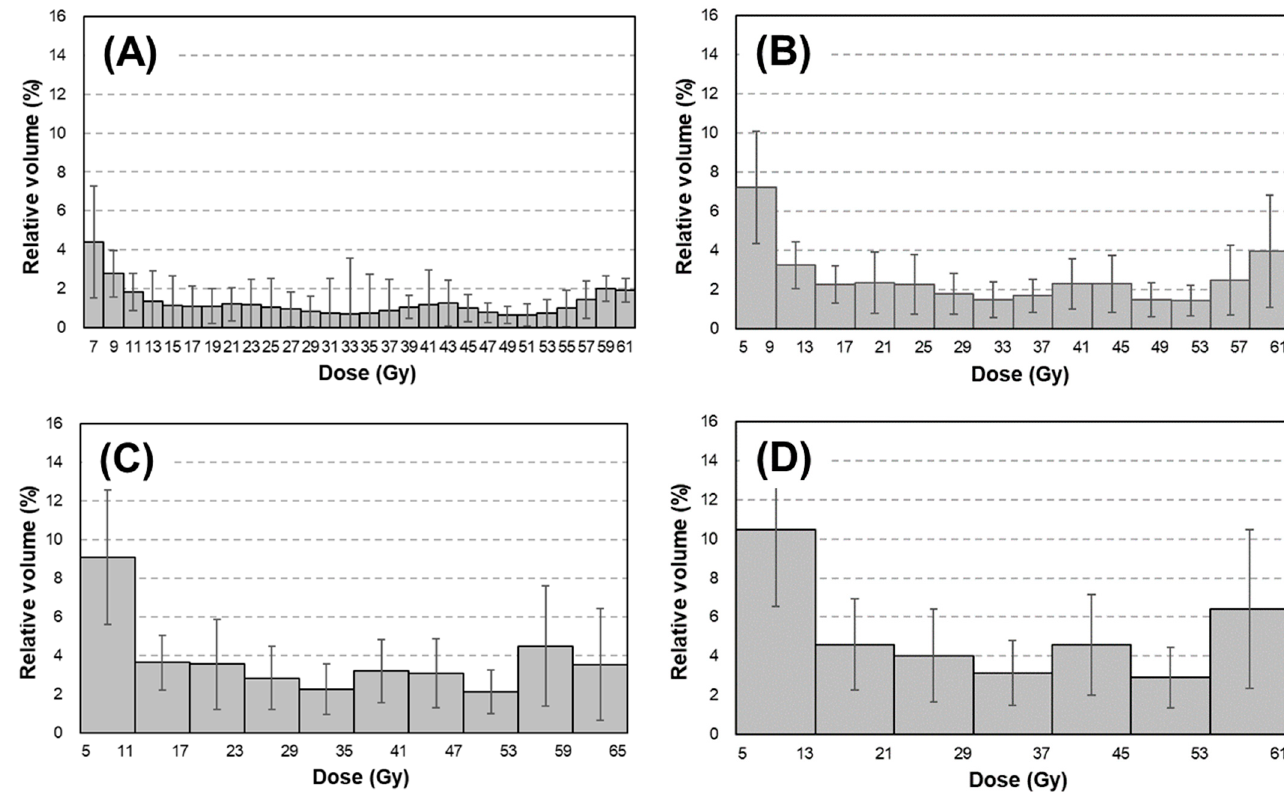
Figure 2. dDVH features calculated with dose bin = 2 Gy ( A ), 4 Gy ( B ), 6 Gy ( C ), and 8 Gy ( D ). Abbre-